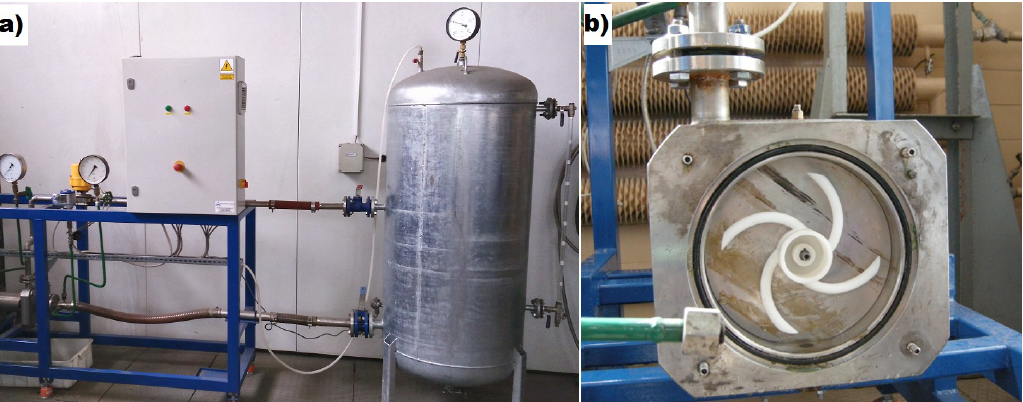
Figure 4: Presentation of test rig – (a) view of test rig, (b) the test rig model pump without the front panel with elliptical type of multi-piped impeller.